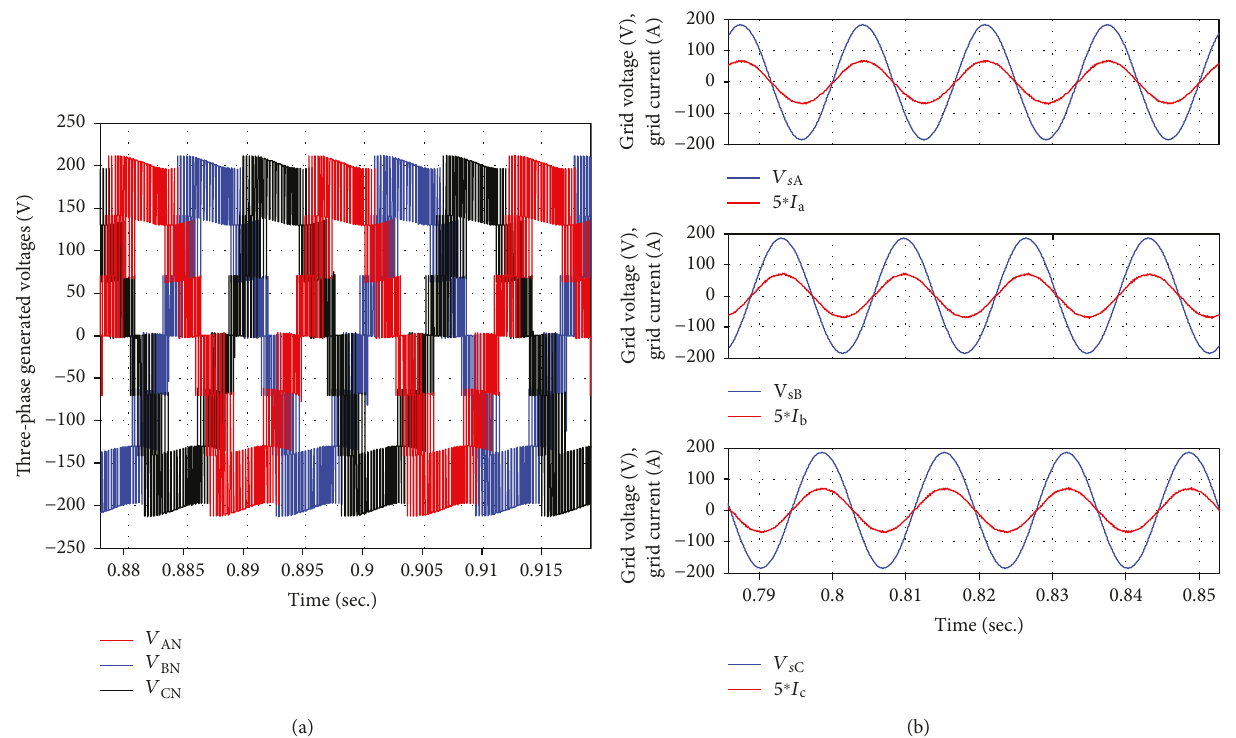
Figure 7: (a) Simulation results of three-phase voltage generated from con fi guration A. (b) Simulation results of grid voltages and grid currents of con fi guration A.